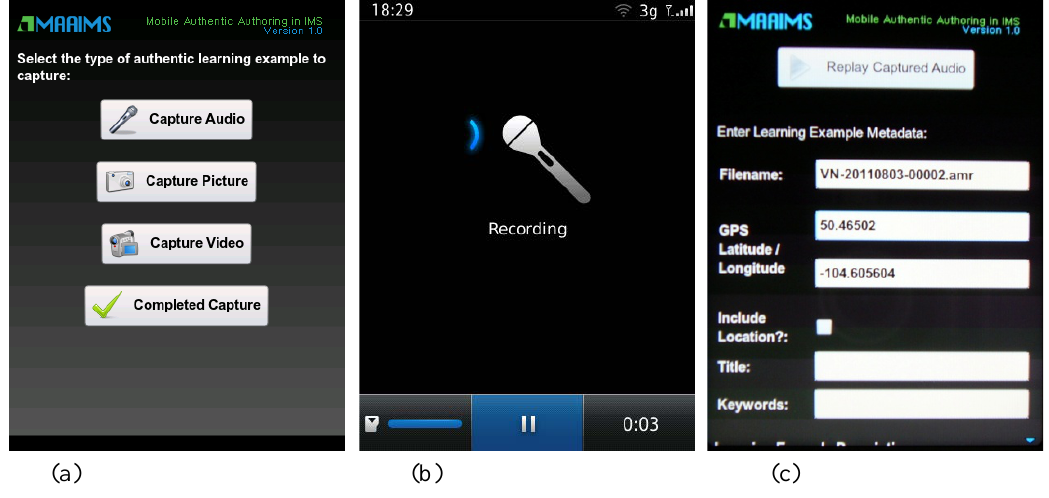
Figure 3 . The authentic learning example capture process: (a) shows the selection of media type, (b) displays the capture, and (c) shows the captured filename, location, and example